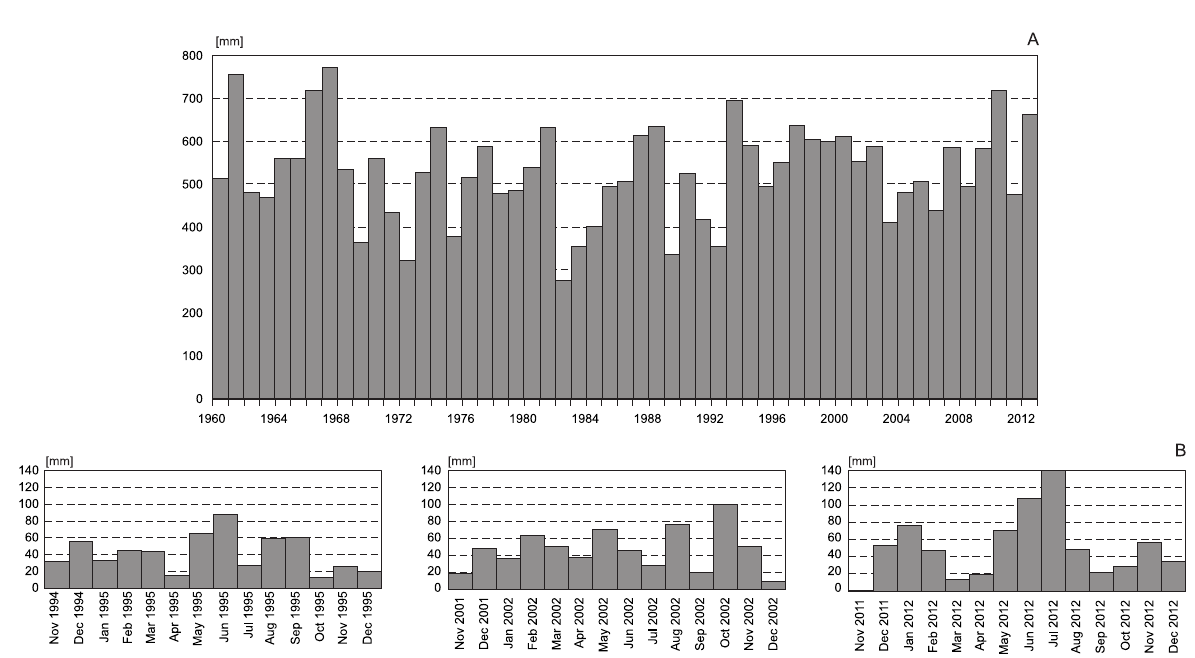
Fig. 2. Annual precipitation in Poznań region in the years 1960–2012 (A). Monthly precipitation in the